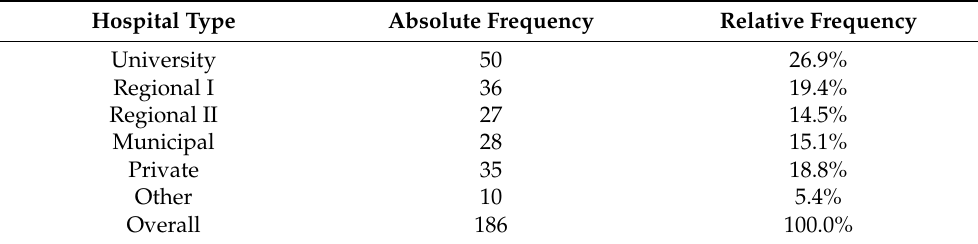
Table 1. Frequency of responses according to the variable hospital